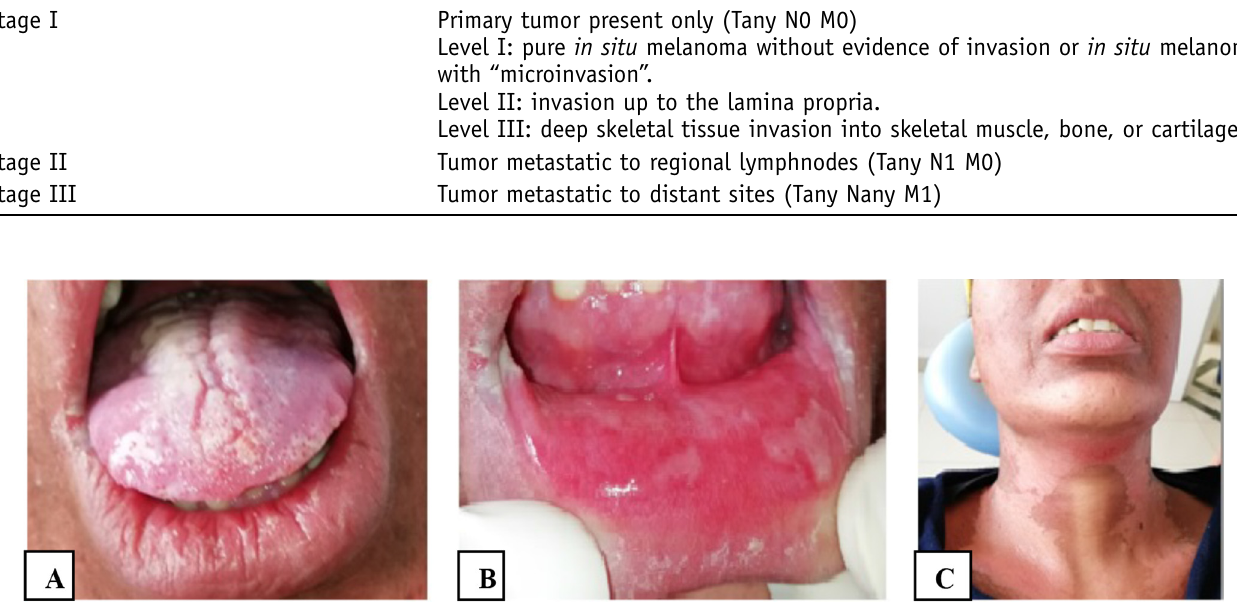
Fig. 3. Radiotherapy sequel: A. Xerostomia. B. Radiation induced oral mucositis. C. Radiation induced